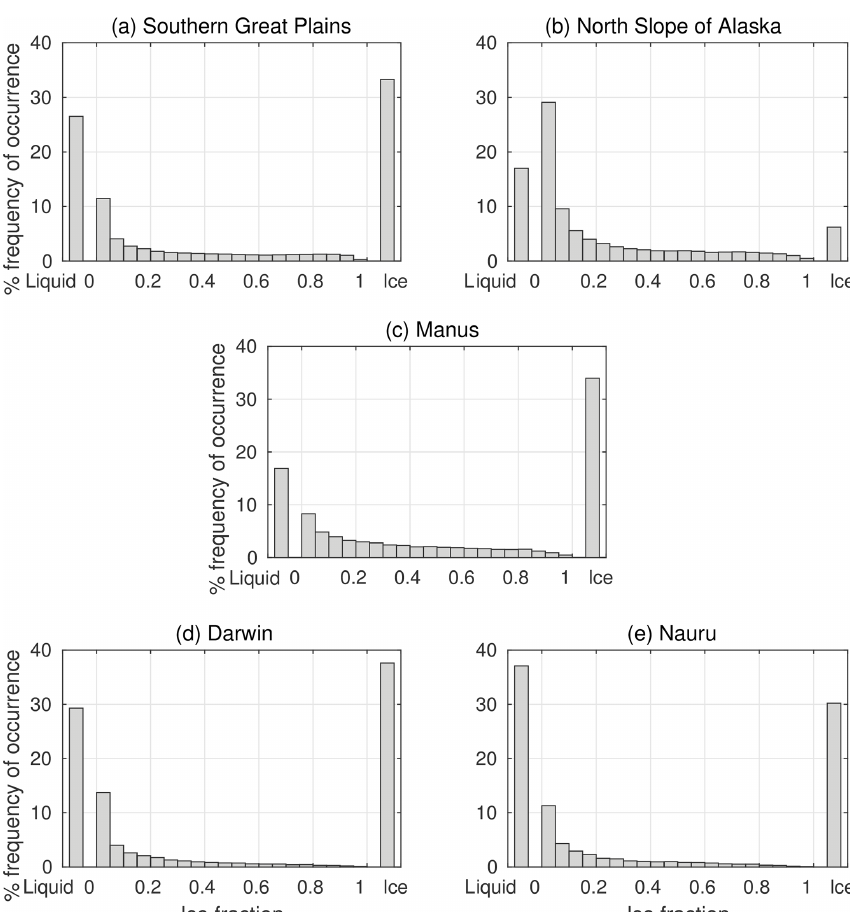
Figure 6. Histograms of ice fraction for real clouds observed at five ARM sites. All available profiles in the period 2005 to 2010 are included for which an AERONET cloud mode retrieval would have been possible (see third and fourth paragraphs of Sect. 4 for conditions). The “liquid” and “ice” bars indicate the fraction of total profiles that contain purely liquid or ice; the remaining bars indicate all other profiles, separated into bins of ice fraction. Data from the Mace et al. (2006) dataset (“ARM